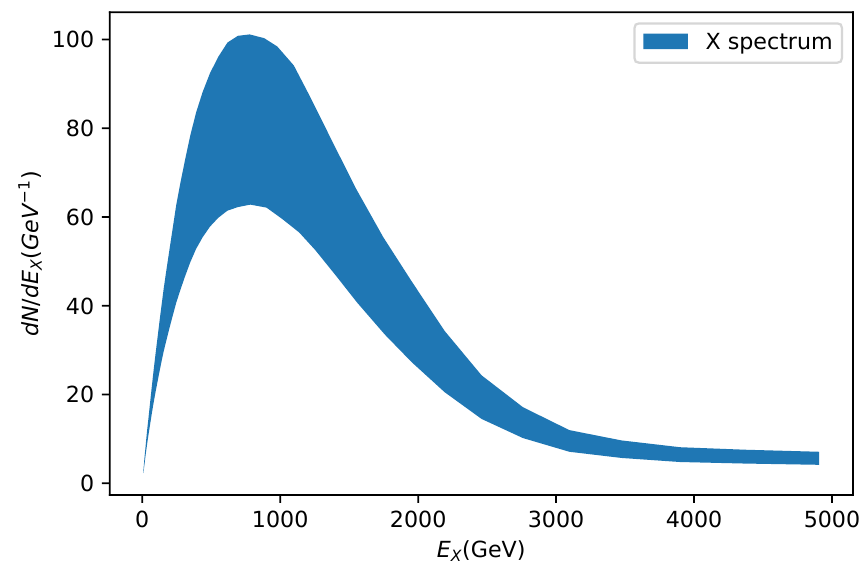
Figure 1 . The spectrum of X particle emitted towards the FASER (cid:23) detector during the run III of LHC with an integrated luminosity of 150 fb (cid:0) 1 and a center of mass energy for colliding p protons of s = 14 TeV. We have taken m X 0 = 3 GeV, m X = 1 GeV and (cid:3) = 2 (cid:2) 10 4 GeV. The gluon distribution function is taken from [35]. The band re(cid:13)ects the uncertainties on the gluon distribution function especially at low momentum